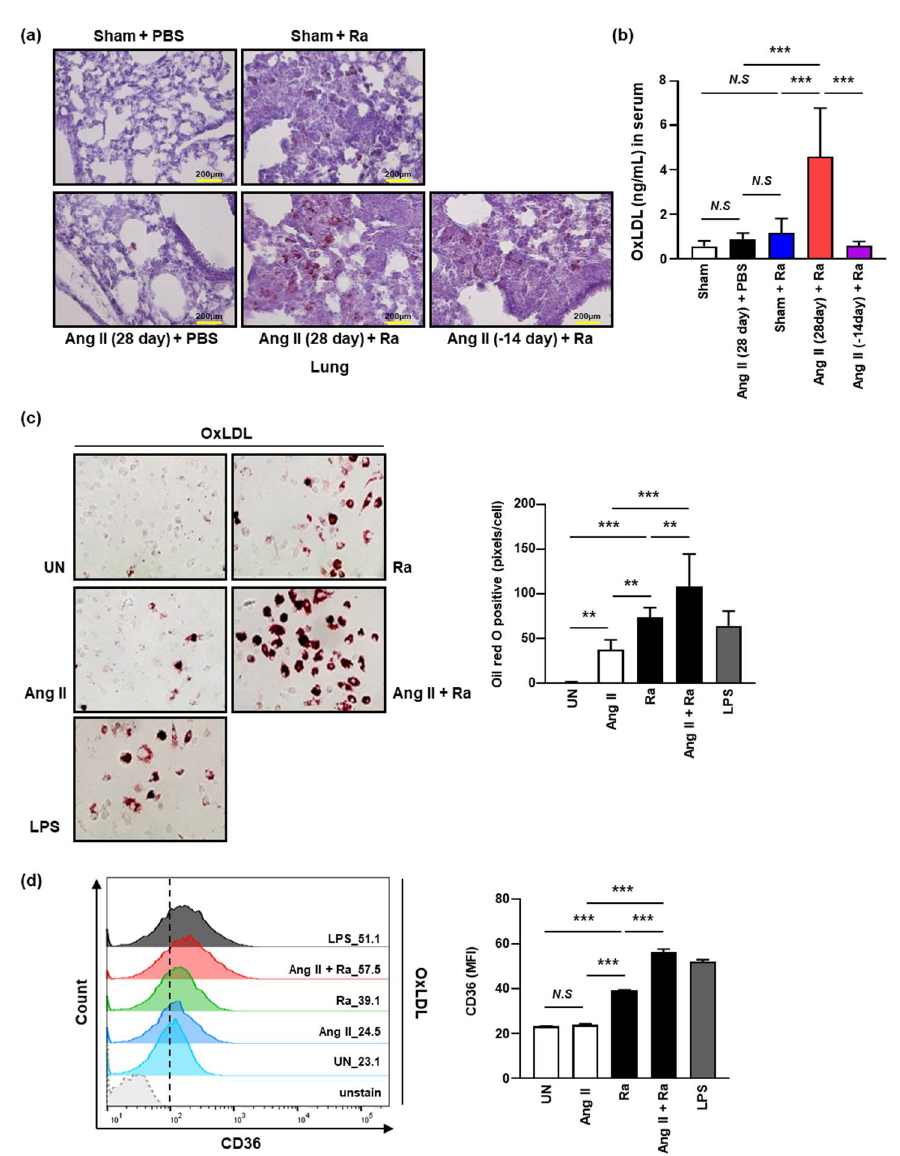
Figure 4. Ang II-induced hypertension provides increasing lipid accumulation during Mtb H37Ra infection in macrophages. ( a , b ) Hypertension was induced in C57BL/6 mice by Ang II (0.7 mg/kg/day) infusion. After 7 days of Ang II infusion, mice were infected by intratracheal injection of 1 × 10 6 CFU of Mtb H37Ra. ( a ) Oil Red O staining for detection of lipid (red) in lung tissue derived from Mtb H37Ra-infected or uninfected mice in the Ang II-induced hypertension and normal control groups (magnification, 40×). Data are presented as representative pictures of each group. ( b ) The OxLDL content was detected by the OxLDL ELISA kit in mice sera at 3 weeks after infection. Released OxLDL in the mouse sera was measured by determining the absorbance at 450 nm (A450). ( c , d ) BMDM cells were pretreated with Ang II (1 μM) for 1 h followed by incubation with 50 μg/mL OxLDL after Mtb H37Ra (MOI = 1) infection. ( c ) Oil Red O staining was used for detection of foamy macrophage formation at 48 h after infection. LPS (500 ng/mL, 24 h) was used as a positive control. ( d ) BMDM cells were incubated with APC-conjugated anti-CD36 antibody (1:100) at room temperature. After washing, the cells were analyzed by flow cytometry. Data are presented as the means ± SD from three experiments. Data are representative of three independent experiments (** p < 0.01, *** p <